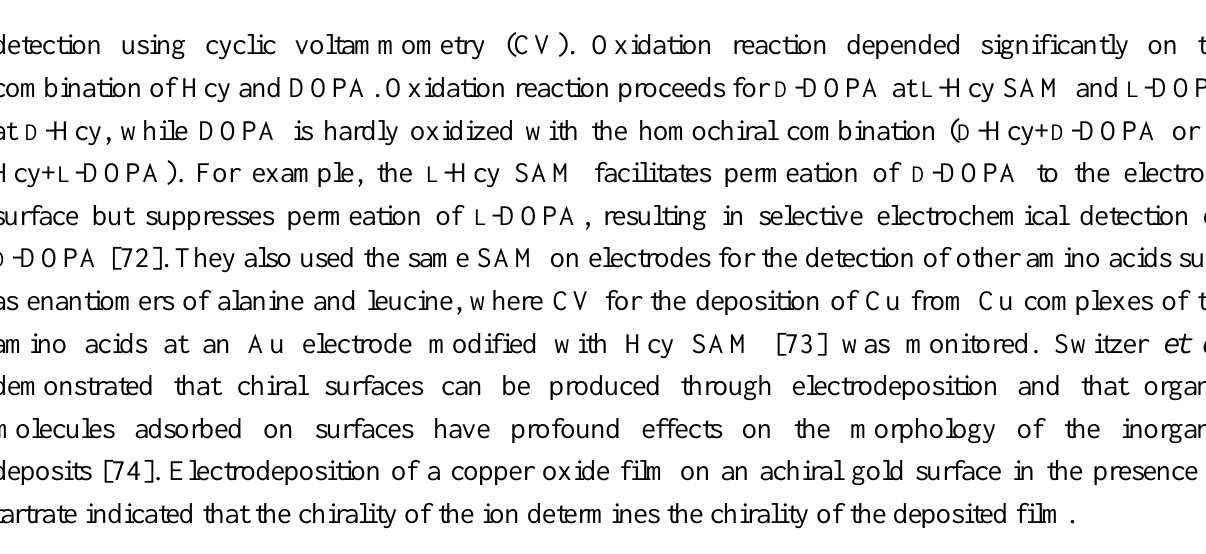
Figure 3. Modification of ITO electrode with Os complex by LB and SAM